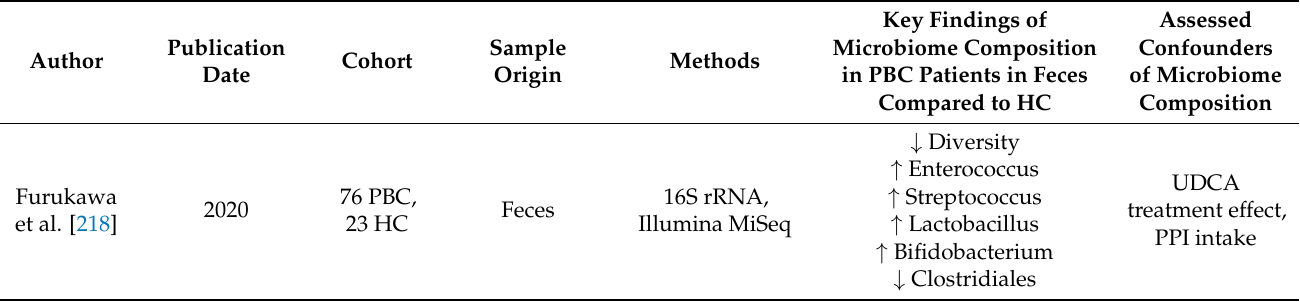
Table 2. Summary of studies investigating the gut microbiome in PBC. Key findings of microbiome composition are influenced by the personal opinion of the authors of this review because it represents a selection of